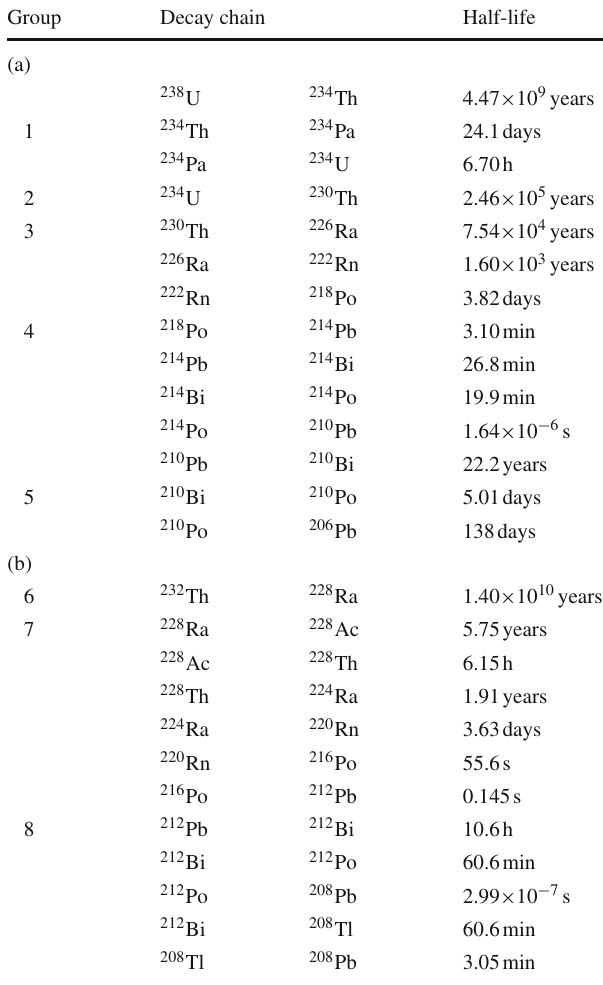
Table 3 Isotopes grouped by half-life: five groups for 238 U (a) and three groups for 232 Th